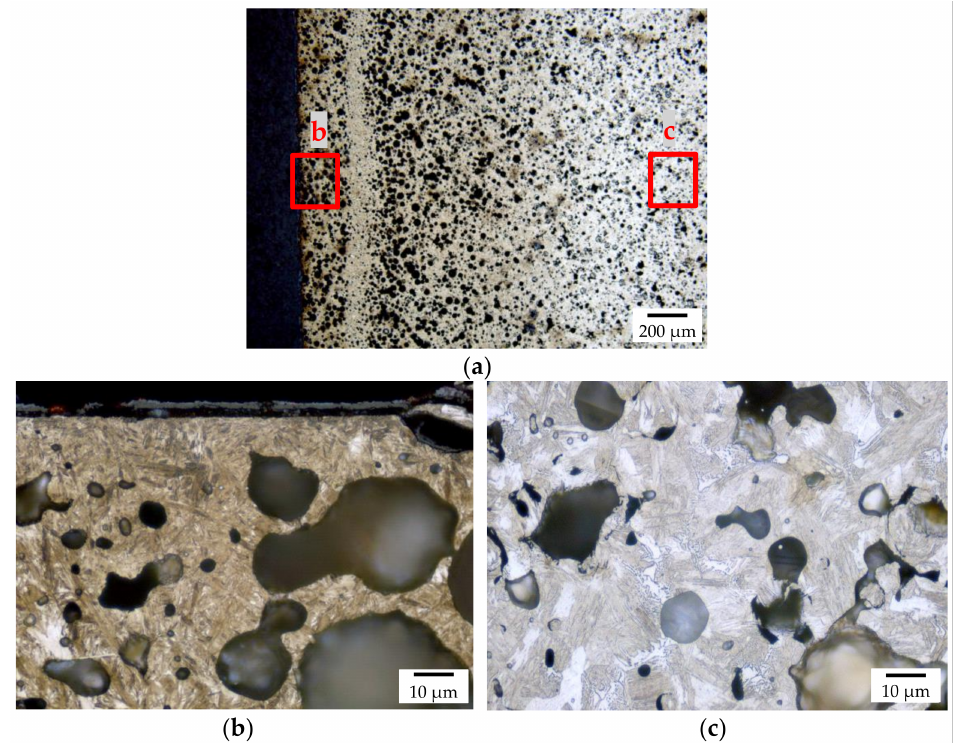
Figure 10. Detailed images of the polished section of the carbonitrided sample with hollow spheres with ( a ) showing the overview of the case, ( b ) showing the surface near layer, and ( c ) showing the core